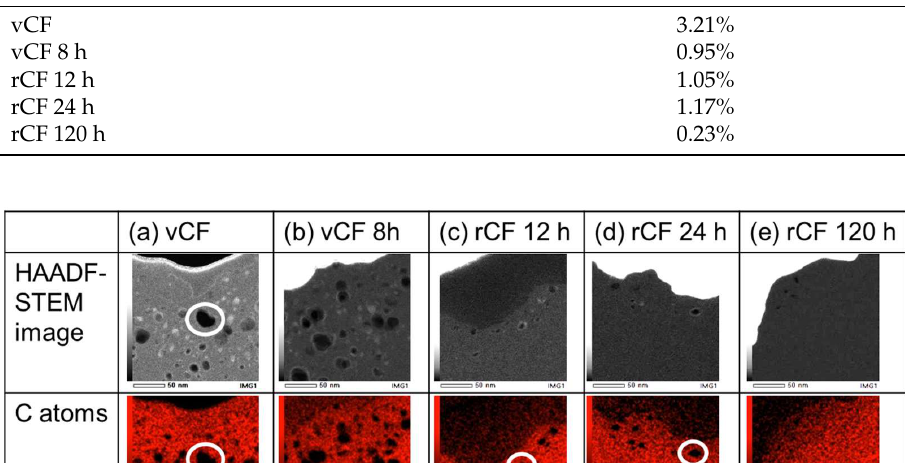
Figure 8. Results of EDX mapping to cross-section for ( a ) vCF, ( b ) vCF 8 h, and rCF ( c ) 12 h, ( d ) 24 h, and ( e ) 120 h, where the white circle represents the presence of the voids and orange circle repre- sents the N or O atoms existing inside the voids. Table 2. Presence ratio of voids existing inside vCF and rCF.